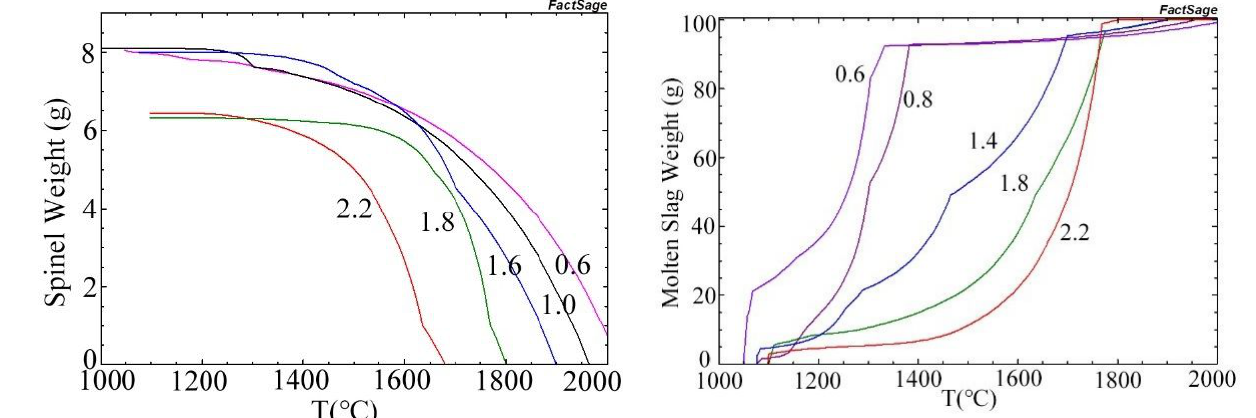
Figure 1: Effect of temperature on the spinel crystals weight.